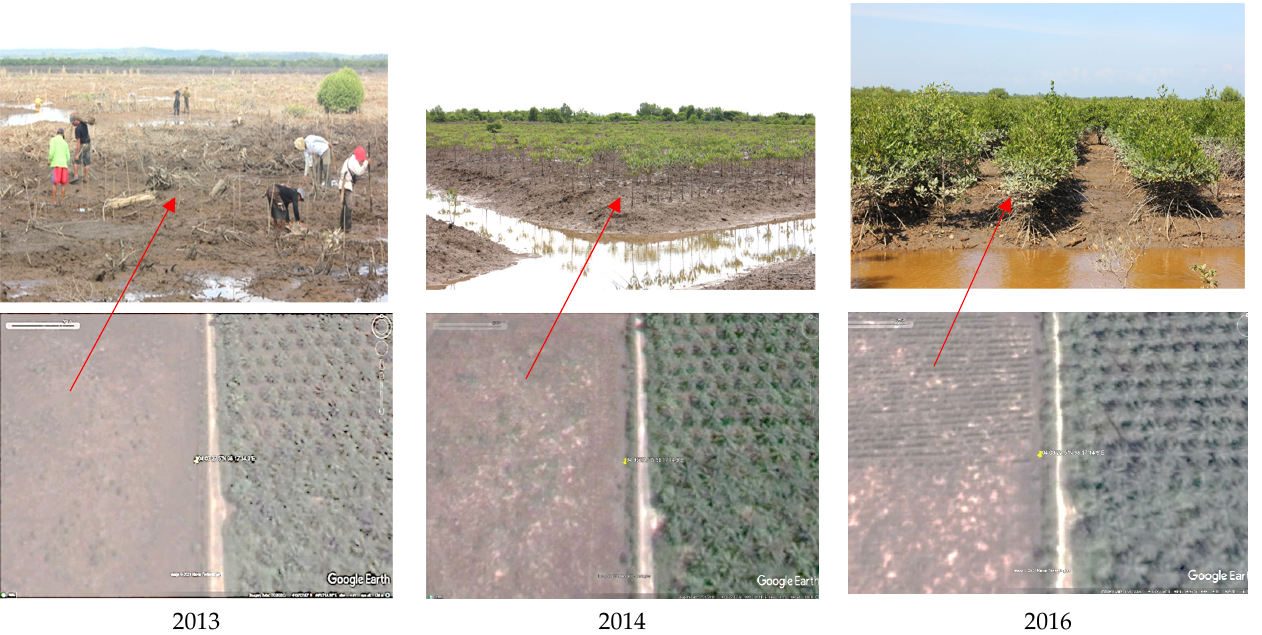
Figure 2. Mangrove rehabilitation in Lubuk Kertang, North Sumatra (Source: Arifin [96]